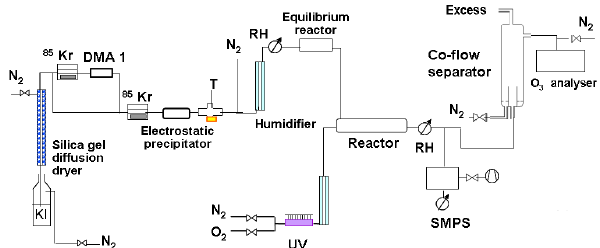
Figure 1. Fig. 1. Overview of the experimental setup.